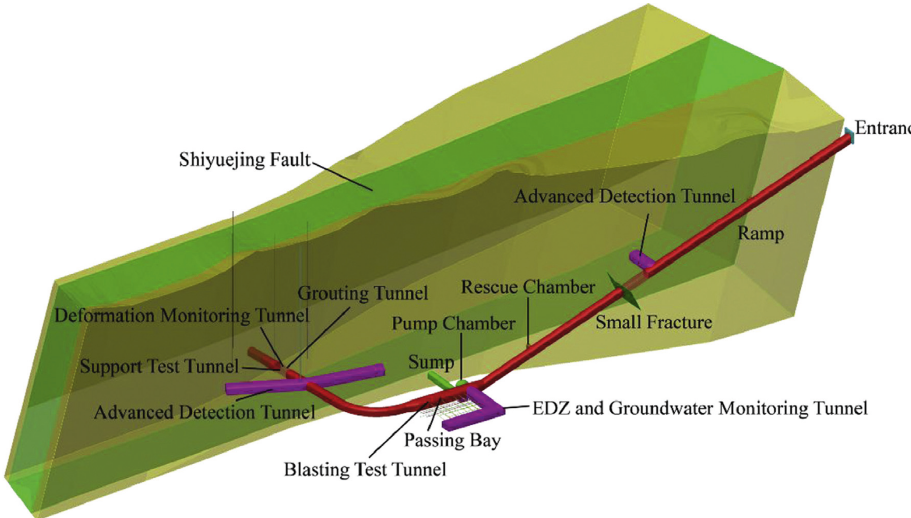
Figure 1: Site for the blasting test.